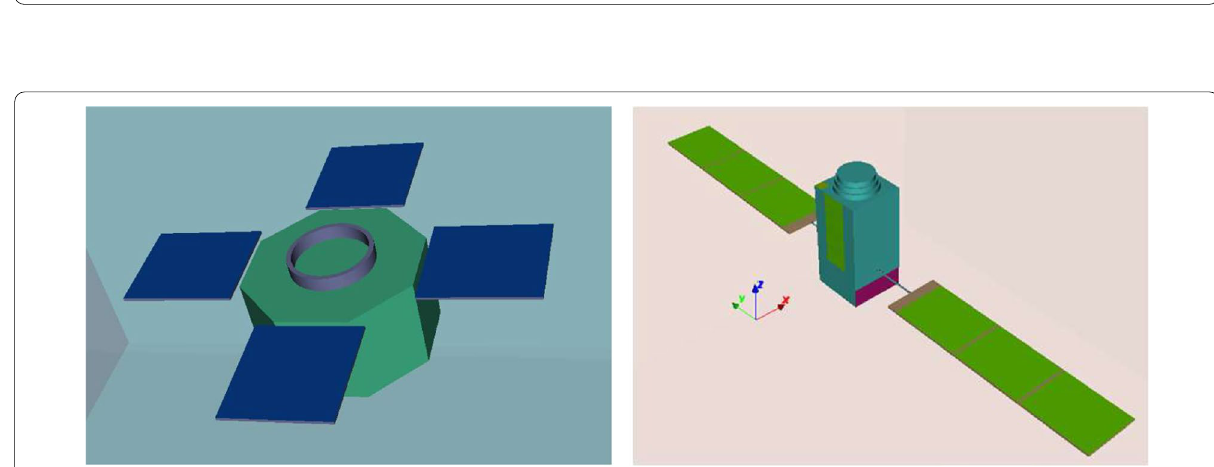
Fig. 4 Extracted observational data at the time when P e peaked, leading to negative charging timing of pressure peak, and simulation data at the simulation time when P sim peaked within 30 min from the time when P e peaked. Scatter plots of a N e versus N sim , b T e versus T sim , c P e versus P sim , ± and d observed T